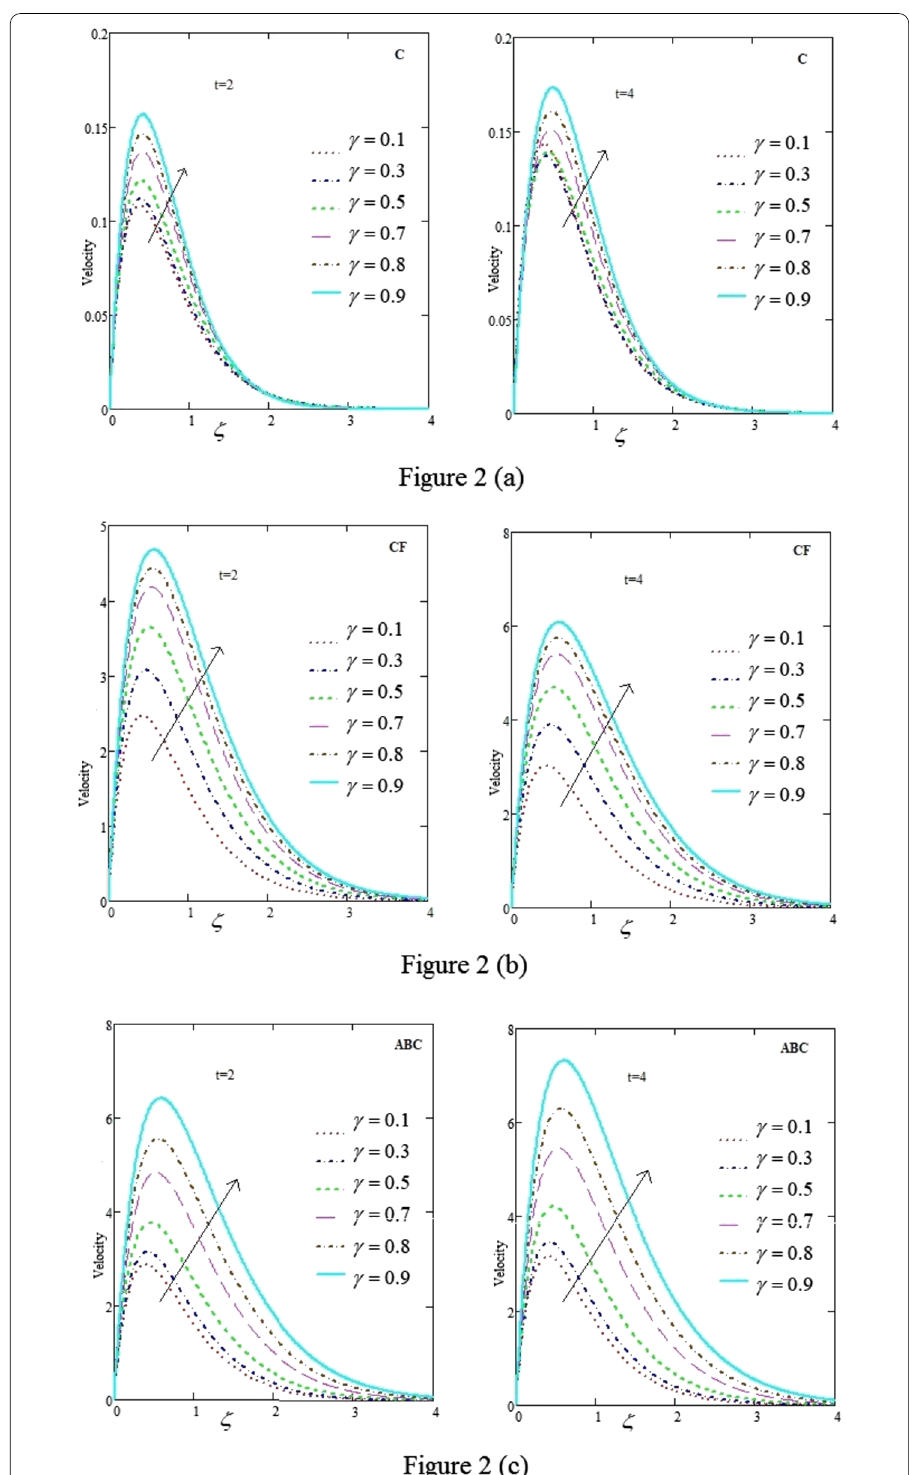
Figure 2 ( a , b , c ). Velocity curves belonging to C, CF and ABC for various values of γ , where M = 4, Pr = 6, Sc = 8, Gr = 6, Gm = 8 and λ =